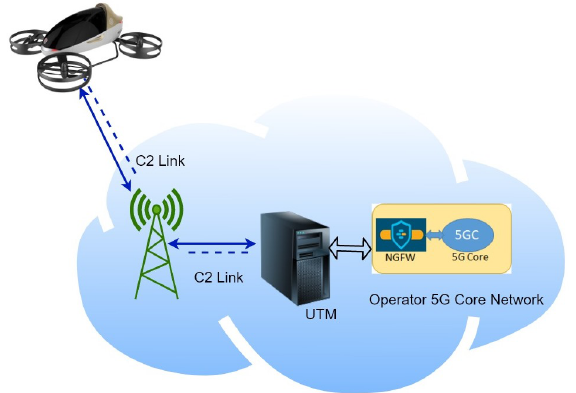
Figure 6. Cellular-connected autonomous UAVs controlled by UTM